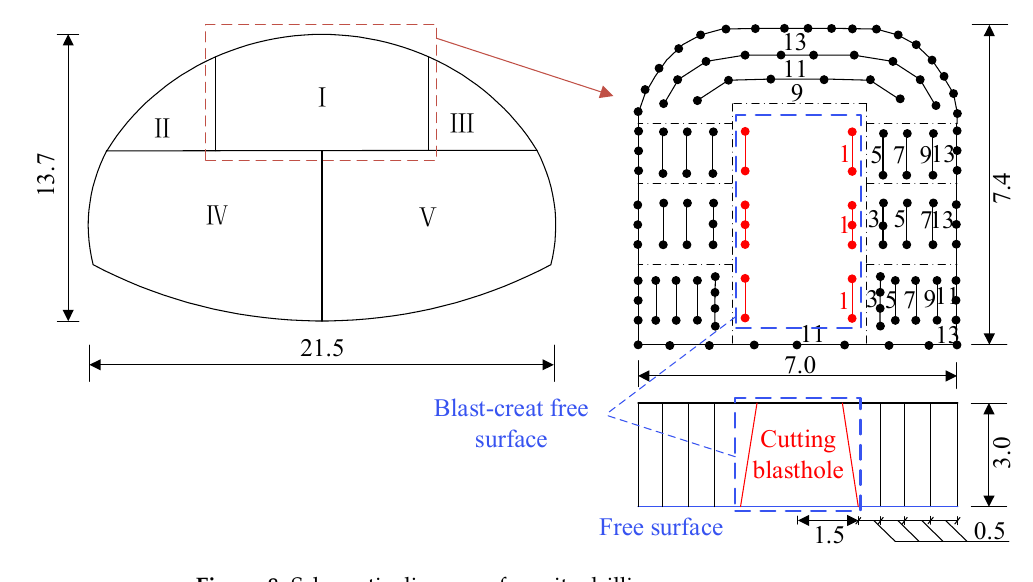
Figure 8. Schematic diagram of on-site drilling. Table 3. Statistical table of blasting parameters for the middle guide tunnel.